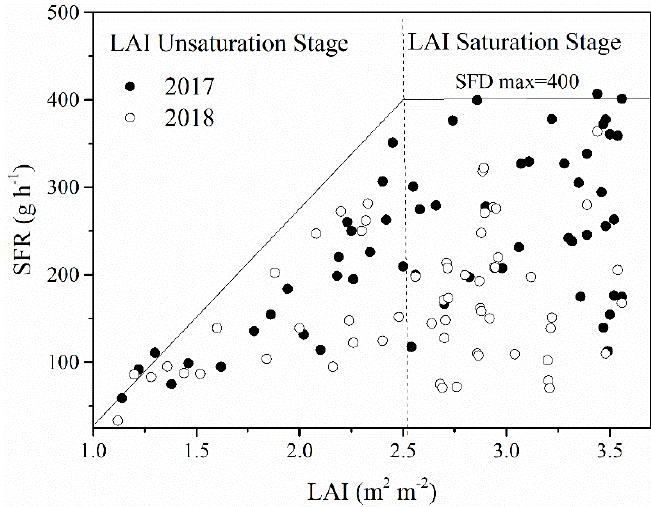
Figure 3. Plots of sap flow rate (SFR) responses to leaf area index (LAI) of grapevine grown in the greenhouse in 2017 and 2018 growing seasons in Northeast China.